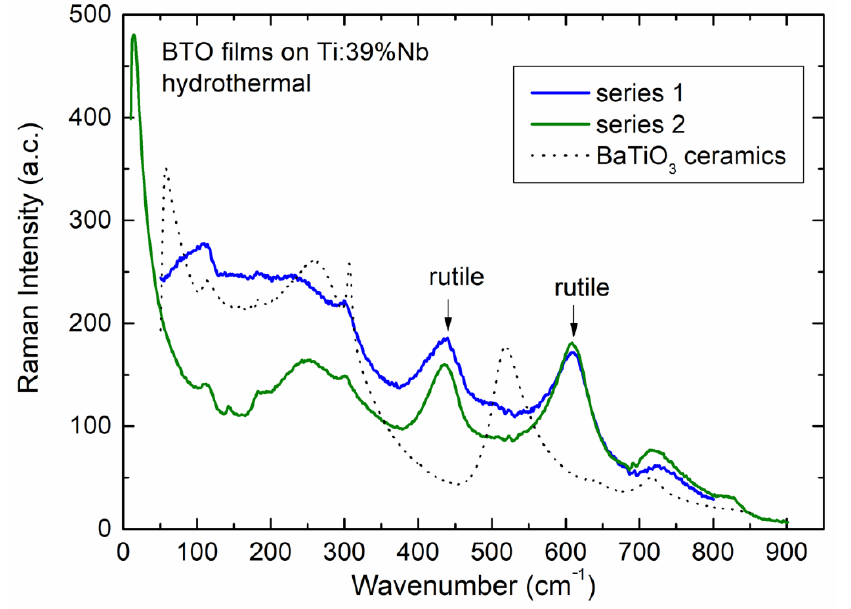
Figure 4. Raman spectra of BaTiO 3 film on Ti39Nb substrates at different points and from different batches (series 1 and series 2). For comparison, the spectrum of pure BaTiO 3 ceramics is shown. Arrows indicate the rutile peaks. The analysis was performed in five regions on each material sample, and a representative graph was selected.